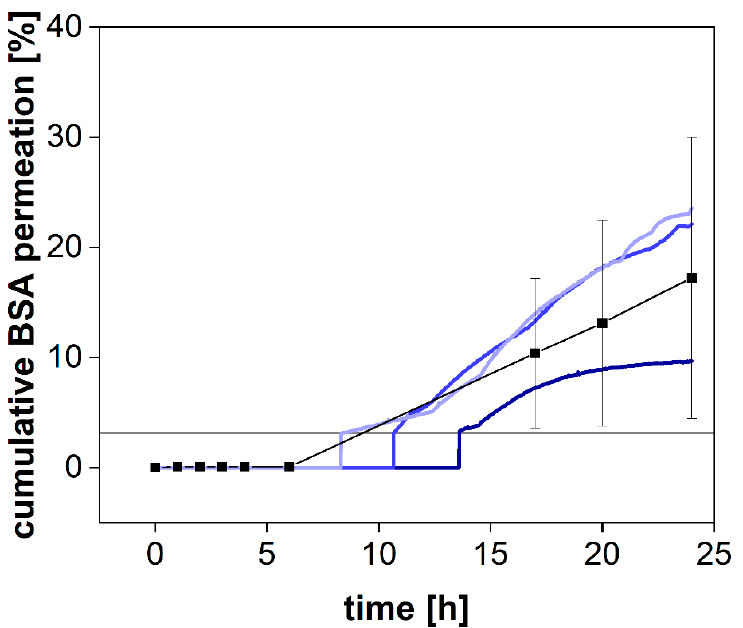
Figure 4. Cumulative permeation of bovine serum albumin (BSA) using SEC-HPLC method (black squares, Mean ± SD, n = 3) or an online UV-VIS dip probe (blue colored lines) at 37 °C and 50 rpm using a 50 kDa RC dialysis membrane. The horizontal grey line denotes the LOQ of the UV-VIS measurement.